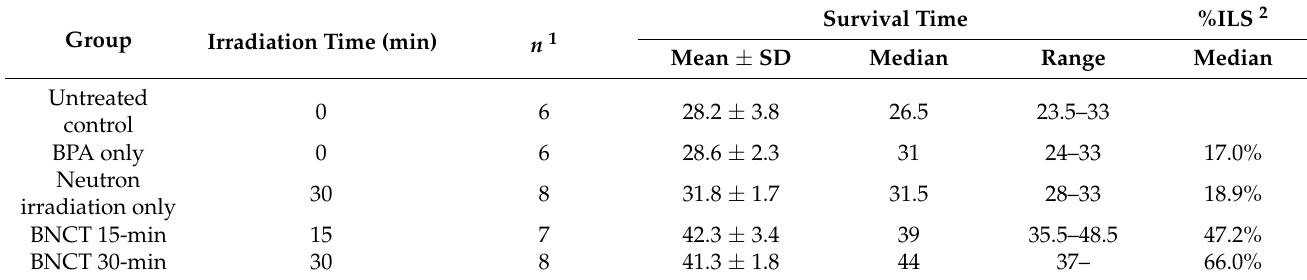
Table 1. Survival times of mouse CNS lymphoma models after neutron